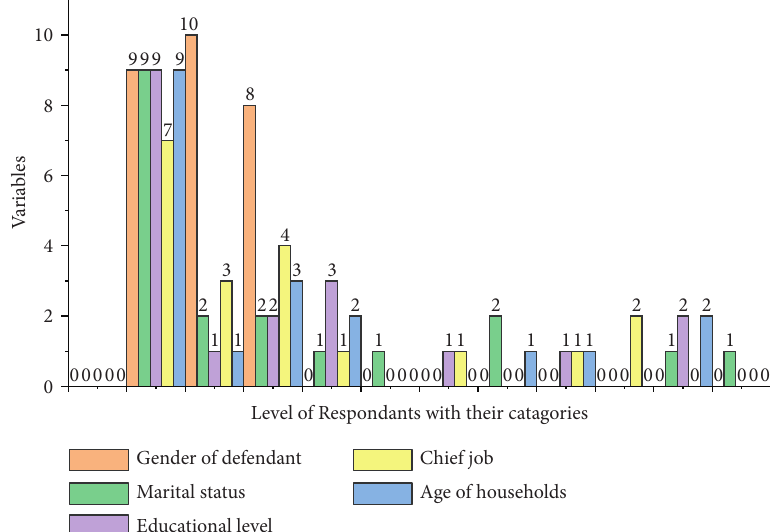
Figure 3: Historical representation of variables and level/types of respondents.